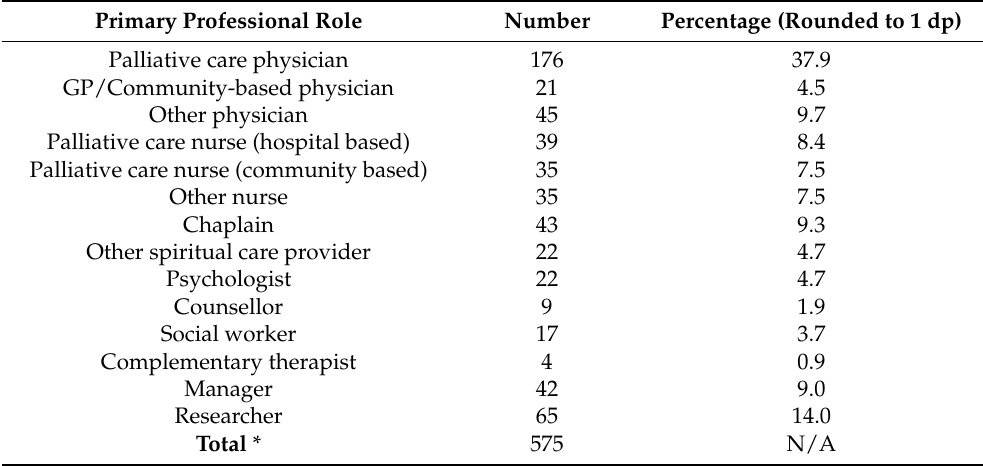
Table 3. Respondents’ primary professional roles (Q9).